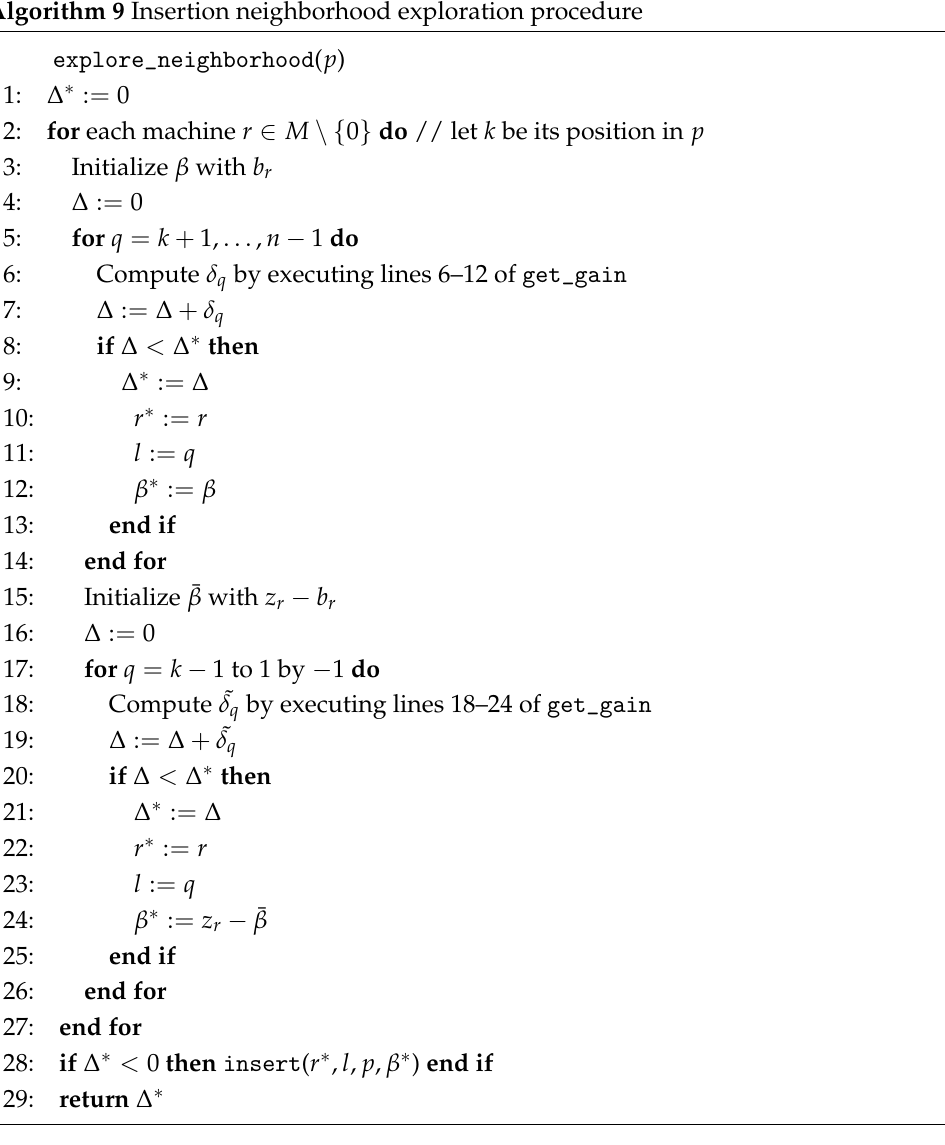
Algorithm 9 Insertion neighborhood exploration